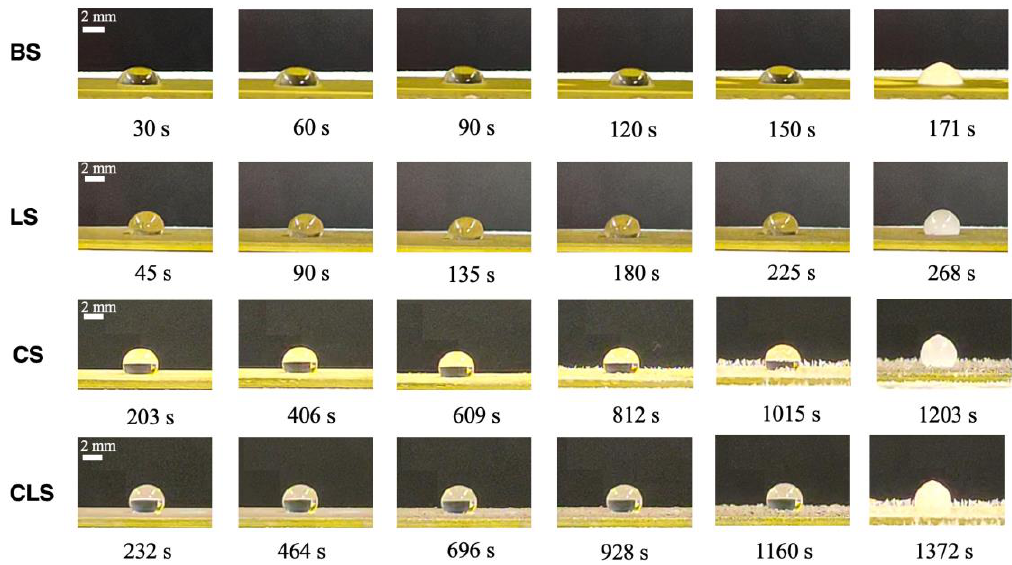
Figure 7. The delayed icing time at −10 °C with droplet size of 20 µL of BS, LS, CS, and CLS.